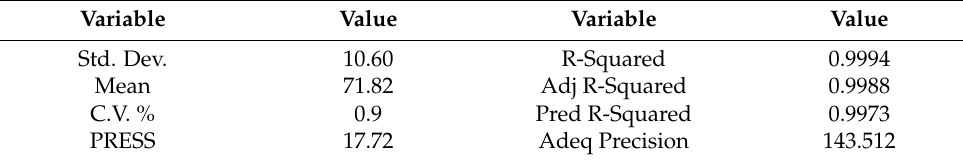
Table 3. Statistical parameters determined by ANOVA.